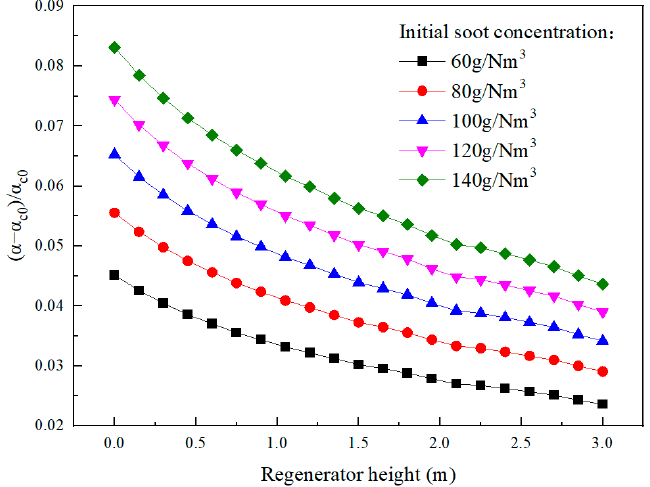
Figure 7. The influence of different concentrations of dust on heat